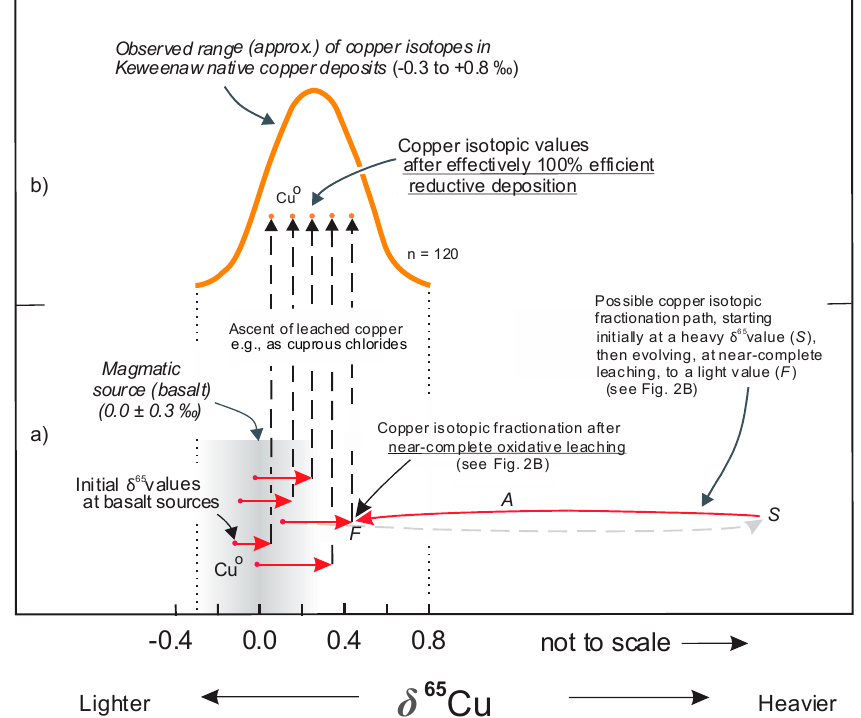
Figure 3. An alternate explanation for copper isotopic fractionation, based ( a ) on near-complete oxidative leaching at the basalt sources and δ 65 Cu values of deep-seated ore solutions that attained the range − 0.3 to +0.8‰ during deep burial metamorphism (lower half of figure, portion a), and ( b ) on having retained that range during up-dip deposition of native copper due to the essentially 100% efficiency of copper deposition (upper half of Figure 3, portion b). Note that during the leaching of copper from deeply buried source basalts (five examples shown), the δ 65 Cu values of developing ore solutions would initially have been isotopically heavy (e.g., δ 65 Cu value S , for one example), and that solutions would have regained lighter values (e.g., δ 65 Cu value F ) during near-complete oxidative leaching of copper (see head of solid red arrow A , representative of the isotopic fractionation toward lighter δ 65 Cu values during oxidative leaching). Having attained well-grouped, slightly heavy δ 65 Cu values ( − 0.3 to +0.8‰, for all 120 samples of analyzed Keweenaw native copper), these ore solutions would then have ascended and deposited native copper with essentially unchanged δ 65 Cu values because of 100% efficient reductive copper deposition (see orange dots, all falling within the observed well-grouped δ 65 Cu values obtained from 120 analyzed native copper samples).